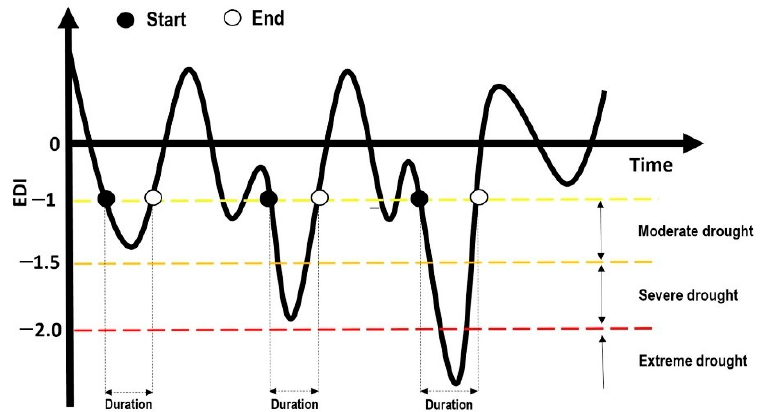
Figure 4. The schematic illustration of drought characteristics (duration, severity) with EDI time series. (Adopted from Kamruzzaman et al. [47]).